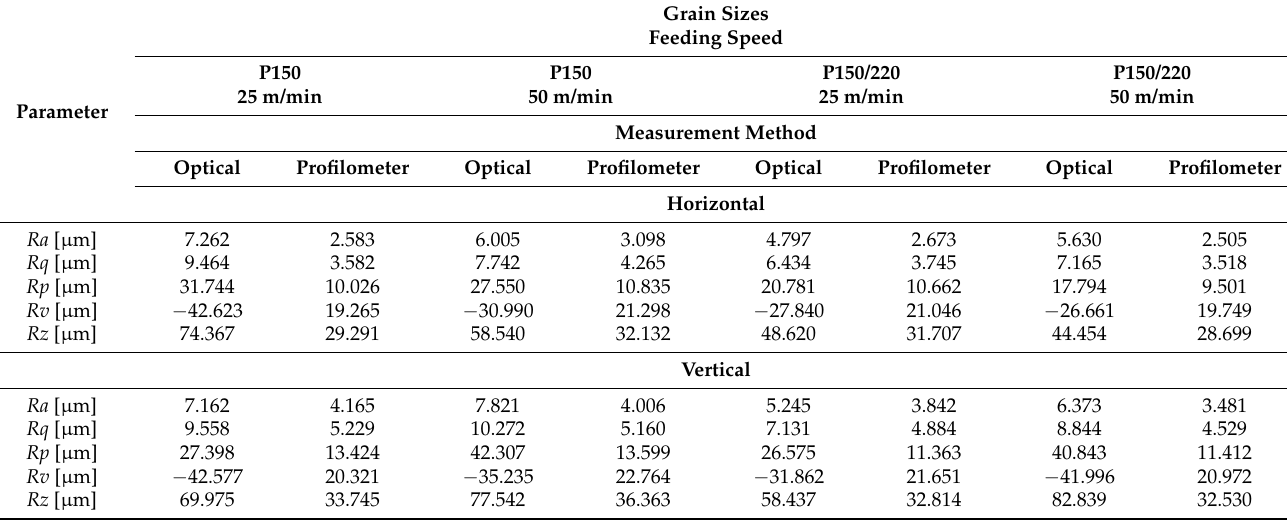
Table 5. Roughness parameters for the C